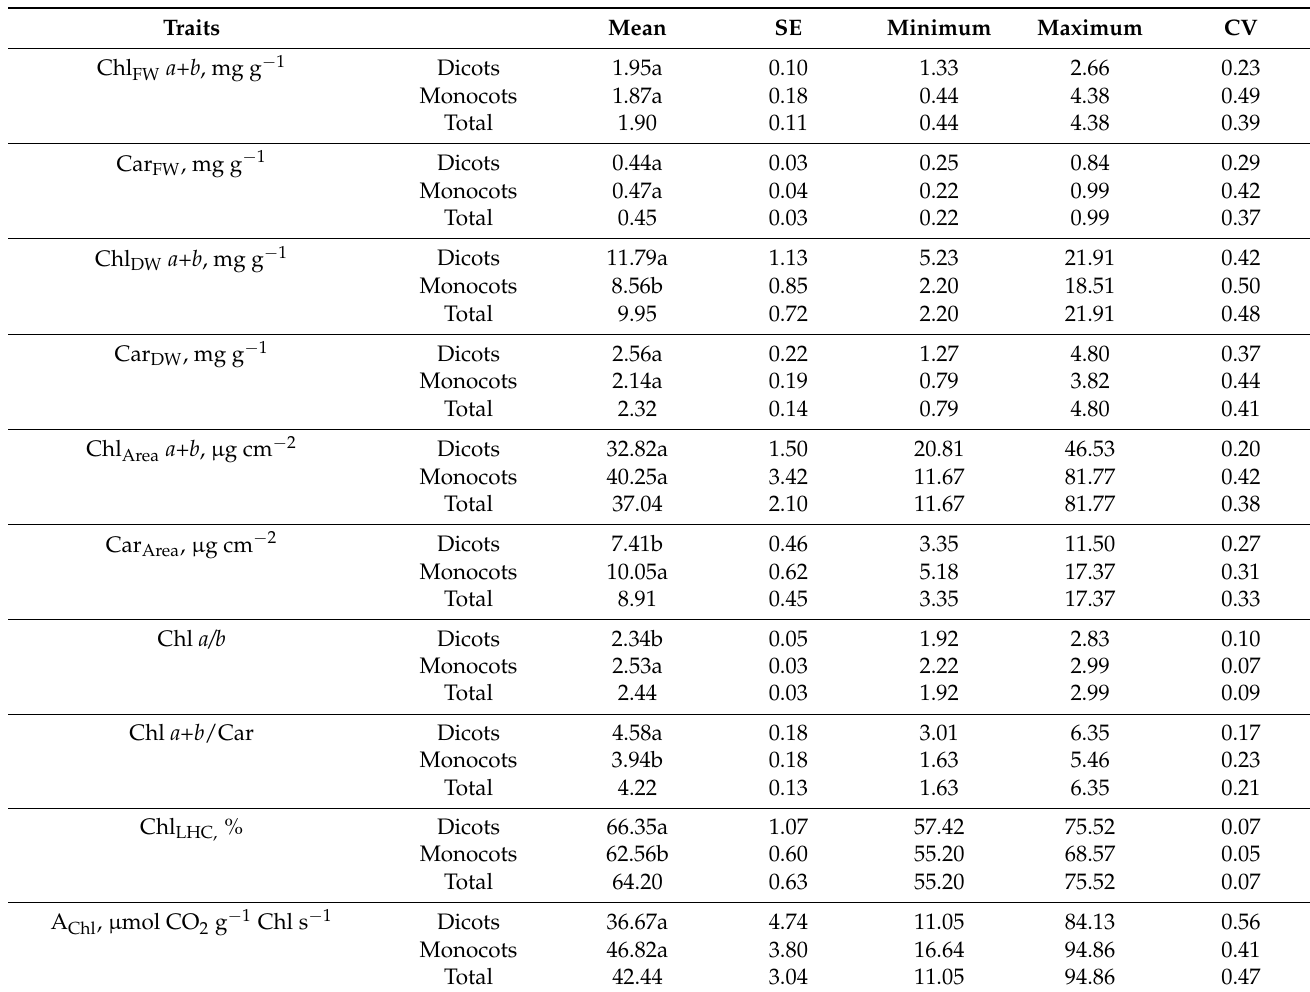
Table 1. Statistics of leaf pigment complex traits in dicotyledonous (n = 19) and monocotyledonous (n = 25) wetland plant species. Different letters denote significant differences between dicots and monocots at p < 0.05. SE, standard error; CV, coefficient of